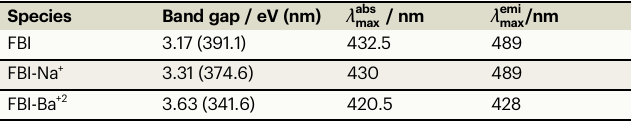
Bandgap values measuredbySTS on Au(111) vs.absorption( λ abs max ) and fl uorescence emission ( λ emi max ) spectralpeaks measured in solution 15 .